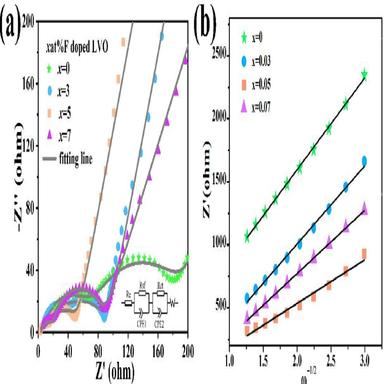
(a) Nyquist plots and (b) Z0 vs u1/2 plots in low frequency zone for different doping levels. Inset of (a) is the equivalent circuit.